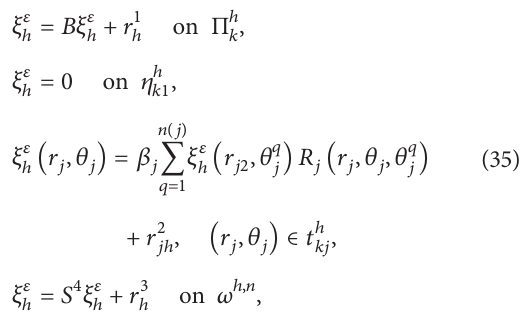
‖𝜁 𝜀 ‖ ℎ 𝐺 𝑆 Iteration